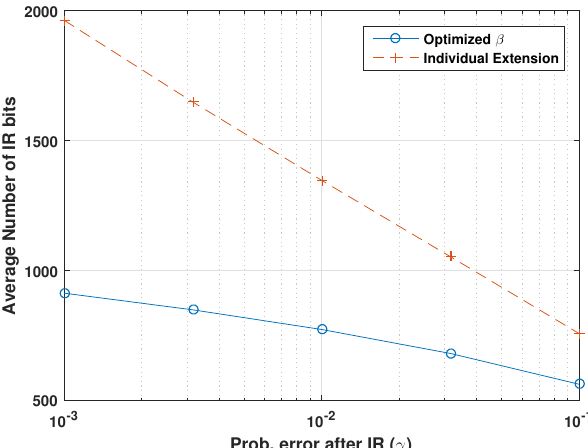
Figure 10. Average number of IR bits required to guarantee that the probability of decoding failure after IR is below γ for all